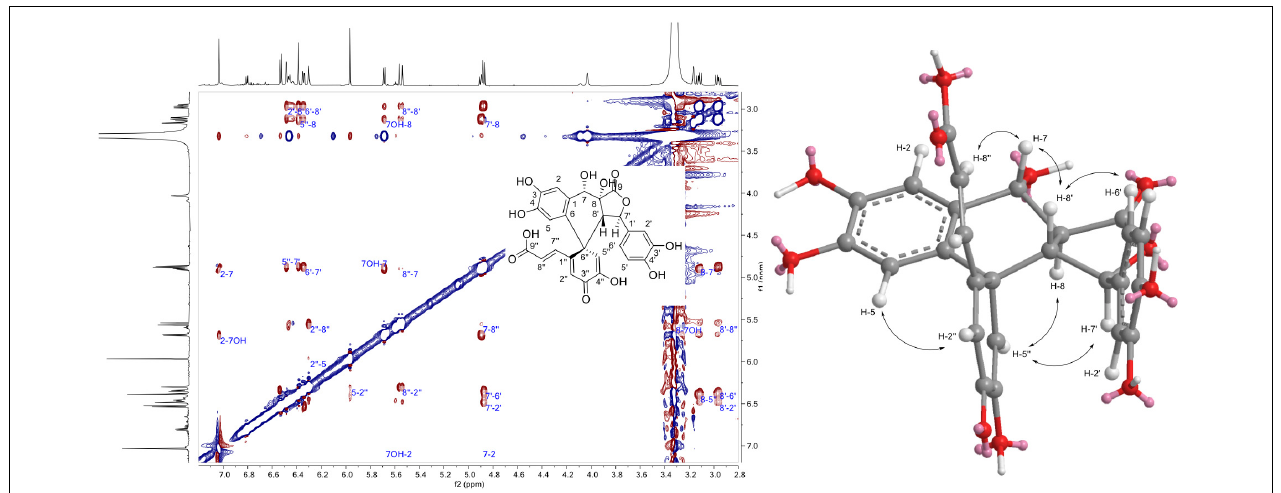
FIGURE 8 | 1 H- 1 H Rotating frame Overhauser Effect SpectroscopY (ROESY) correlations observed for compound 1.